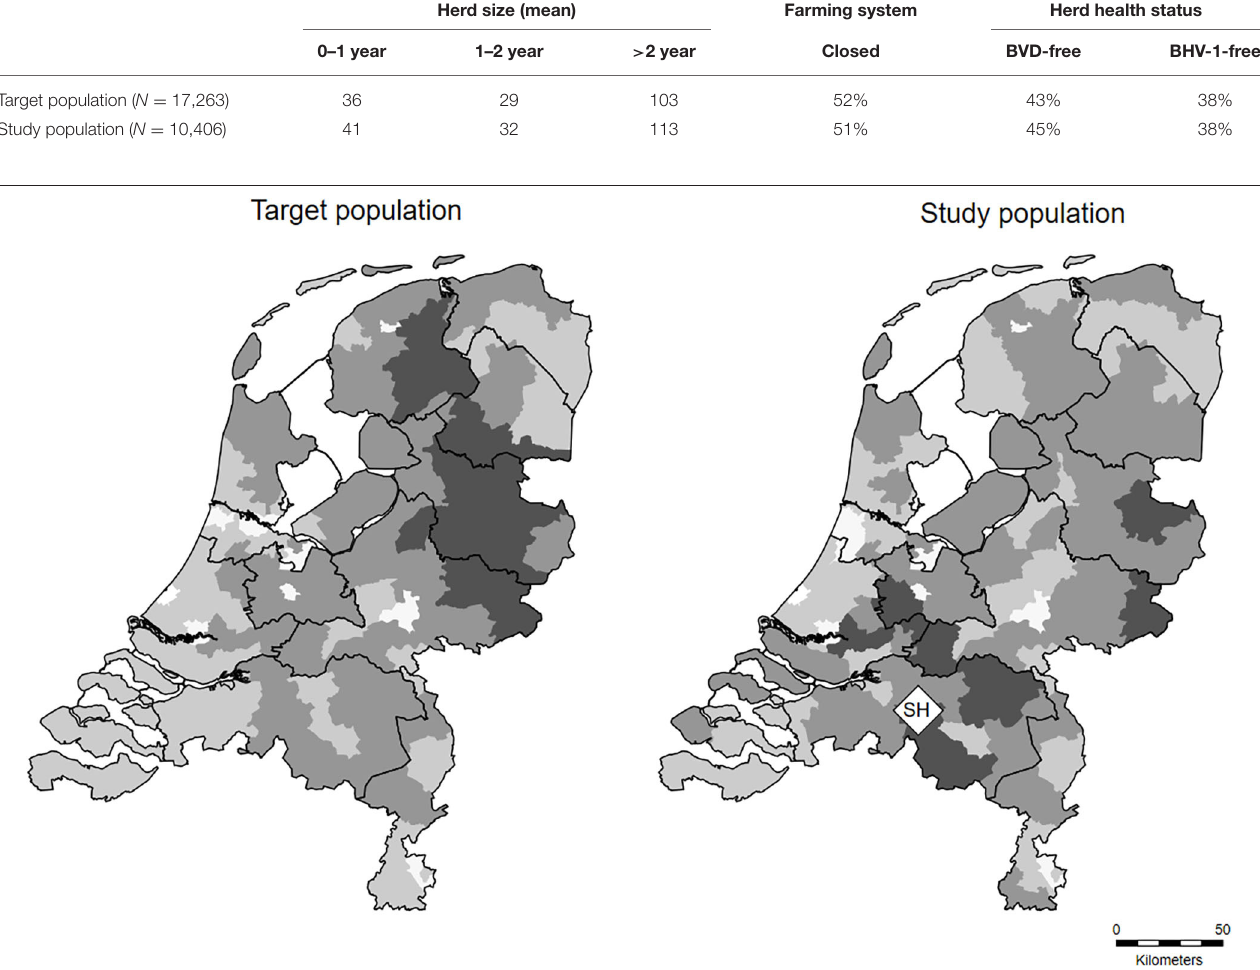
FIGURE 1 | Regional distribution of dairy herds in the target population and the study population per two-digit postal district over the period 2015–2018, with the slaughterhouse of study indicated with a diamond symbol (“SH”). Increasing color intensity of areas correspond with increasing cattle herd density.